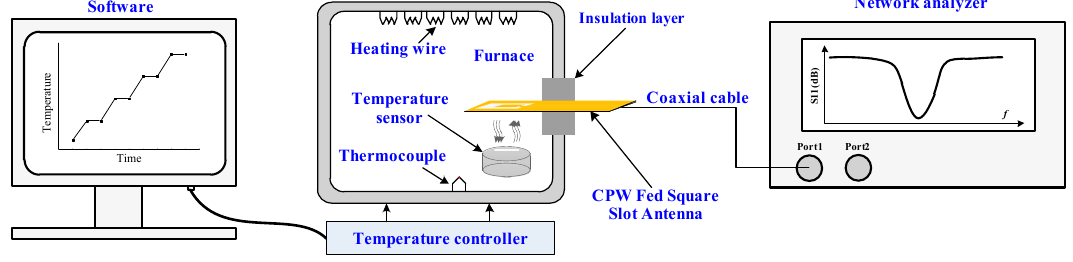
Figure 7. Schematic of the high-temperature measurement setup using a furnace.